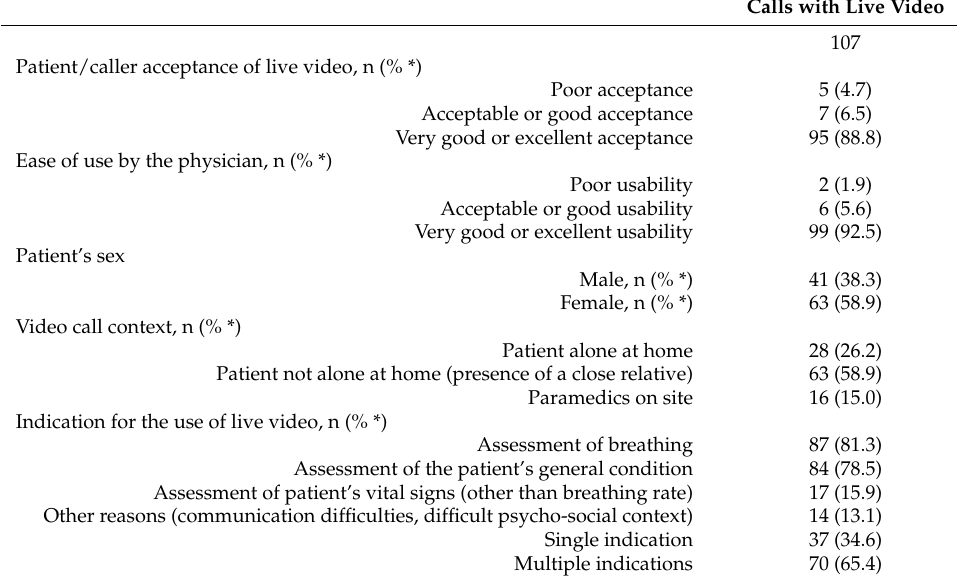
Table 3. Live video calls assessments by the EMCC Physician